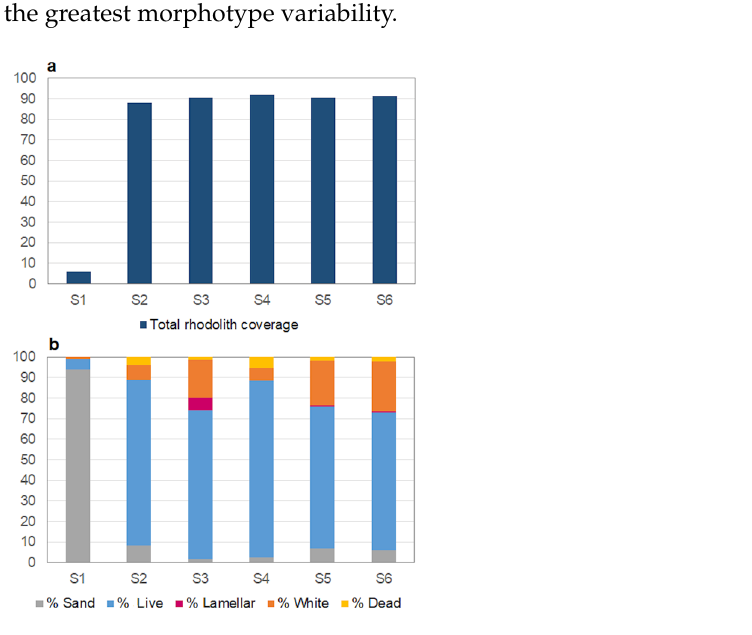
Figure 6. ( a ) Boxplot of three different morphotypes percentage in the sampling sites; ( b ) ternary plot of the three morphotypes (coverage in %) per sampling site. The PERMANOVA performed on the morphotype dataset showed significant differ- ences between sampling sites (Pseudo–F = 43.994; p < 0.01). Pairwise comparisons were all significantly different, except for S2–S4 and S5–S6. The Principal Coordinates analysis (PCO) explained 81.8% of the variation in the data, with PCO1 axis explaining 50.6% and PCO2 axis 31.2%. S1 is separated along the PCO1 axis, while transects are separated along the PCO2 axis (Figure 7a). PERMANOVA performed on the dead/live dataset, including bare coverage, showed significant variability between sampling sites (Pseudo–F = 152.26; p < 0.01). Pairwise comparisons were all significantly different except for S3–S4, S3–S5 and S5–S6. Differences in dead/live ratio are visualized on the PCO graph; the 85.5% of the total variation was explained by the PCO1 axis, along which S1 separates. “Bare” correla- tion vector explains this diversity (Figure 7b).